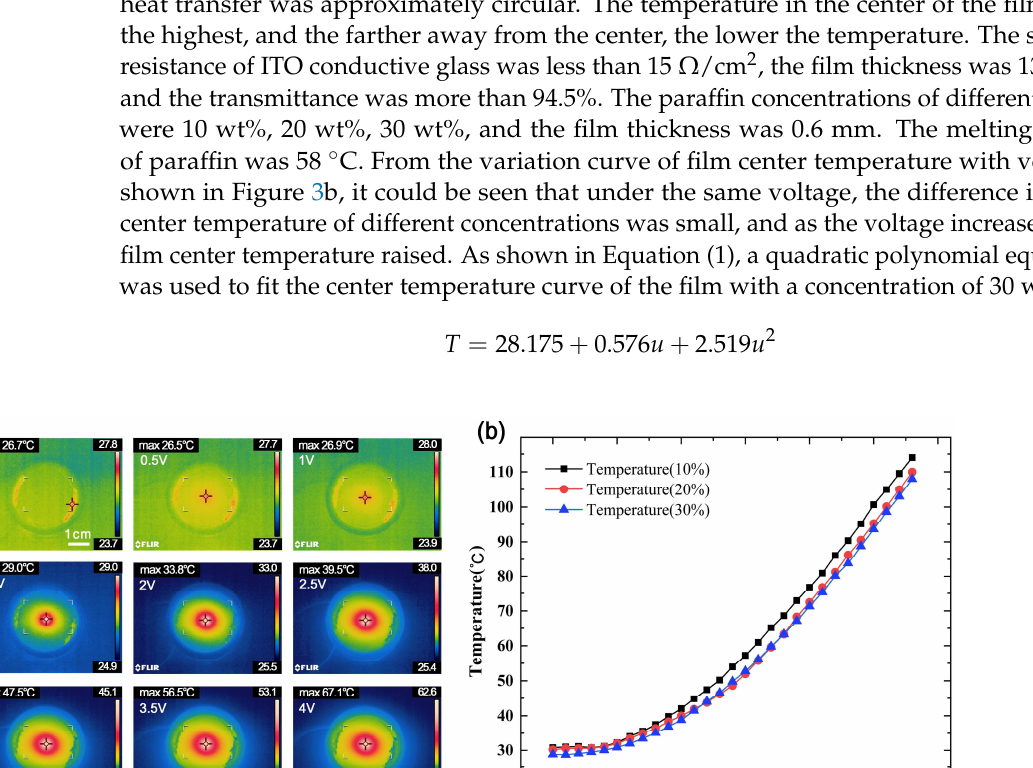
Figure 3. ( a ) Infrared thermal images of film surfaces under different voltages. ( b ) Variation curve of film center temper- ature with voltage.